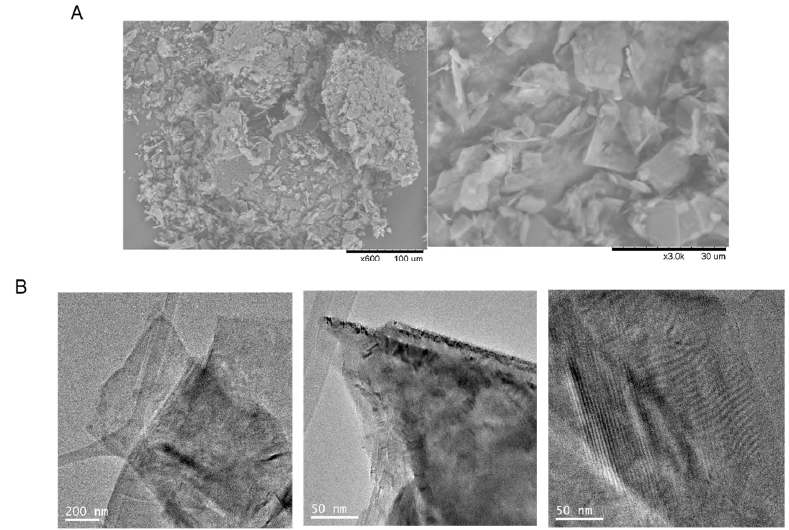
Figure 5. Characterization of biographene-1 -CAL-B. ( A ) SEM Images. ( B ) TEM images.